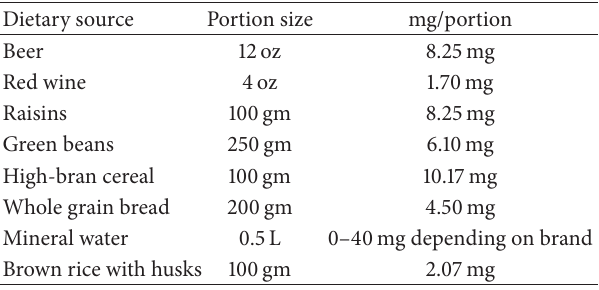
Table 1: Common dietary sources of silicon [58,